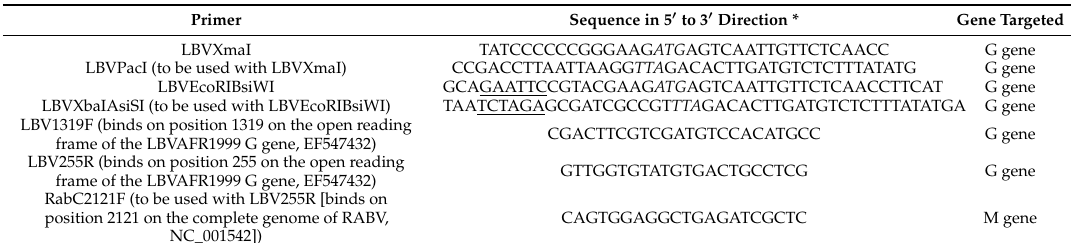
Table 1. Primers used for amplification or sequencing of the Lagos bat virus matrix and glycoprotein genes.